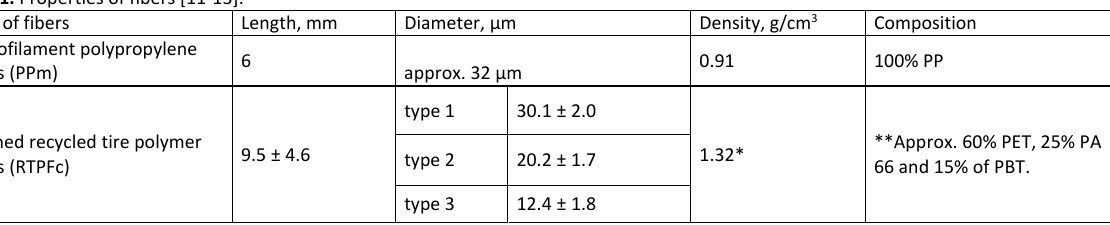
Table 1. Properties of fibers [11 ‐ 13].